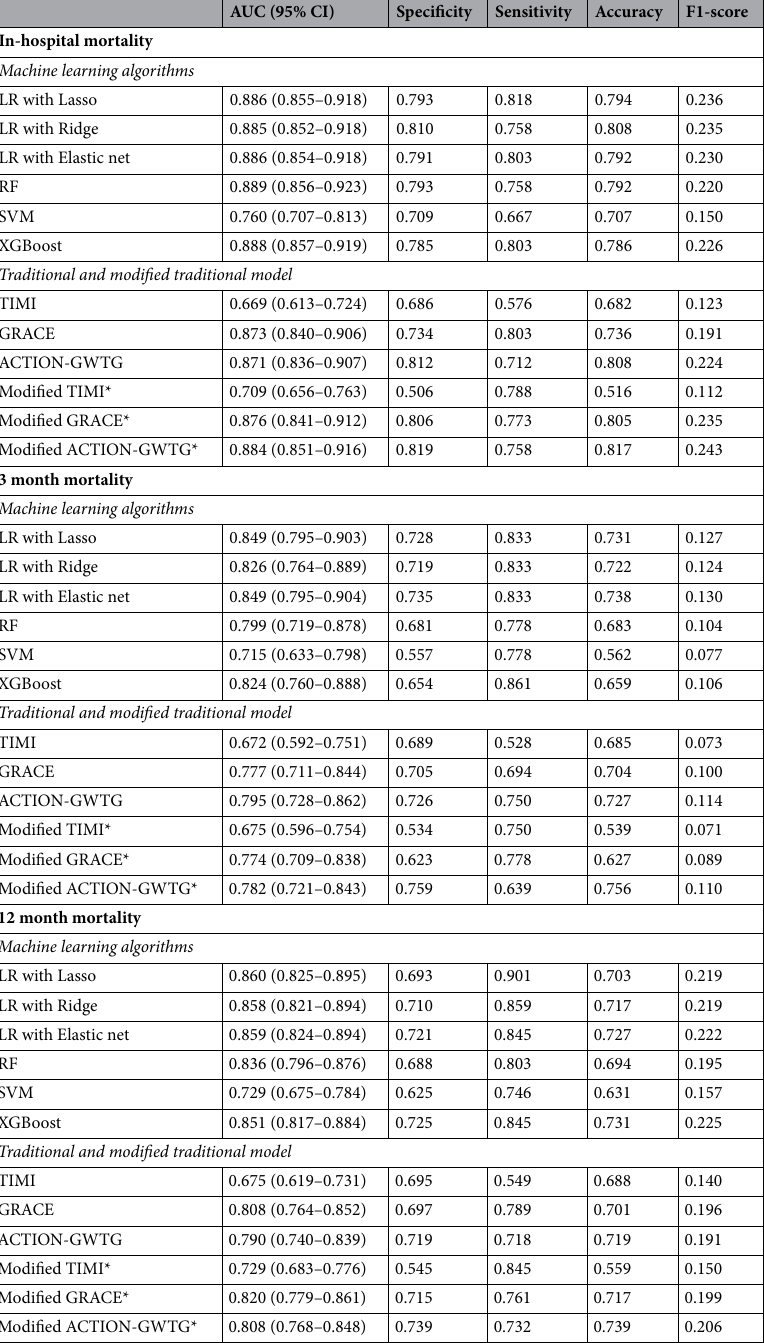
Table 3. Performance of the mortality prediction models in Non-ST-segment elevation myocardial infarction using the traditional features. AUC, area under the receiver operating characteristic curve; LR, Logistic regression; Lasso, L1 penalty; Ridge, L2 penalty; Elastic net, Elastic net penalty; RF, Random Forest; SVM, Support Vector Machine; XGBoost, Extreme Gradient Boosting; Thrombolysis in myocardial infarction, TIMI; Global registry of acute coronary events, GRACE; Acute coronary treatment and intervention outcomes network—Get With The Guidelines, ACTION-GWTG. *Traditional models were modified using the recalculated parameters for TIMI, GRACE, and